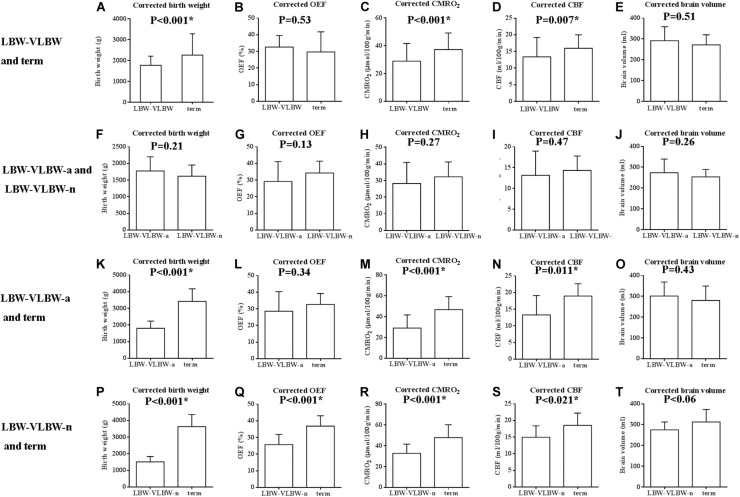
Box plots of corrected birth weight, OEF, cerebral metabolic rate of oxygen (CMRO2), cerebral blood flow (CBF), and brain volume, comparing low birth-weight/very low birth-weight (LBW-VLBW) and term newborns, LBW-VLBW-a and LBW-VLBW-n subsets, LBW-VLBW-a subset and term newborns, and LBW-VLBW-n subset and term newborns: (A,K,P) Corrected birth weights of LBW-VLBW newborns (+/-MRI abnormalities) exceeded by those of term newborns; (C,D,M,N,R,S) Corrected CMRO2 and CBF rates differed significantly in LBW-VLBW and term neonates (p < 0.001, p = 0.007), LBW-VLBW-a subset and term neonates (p = 0.001, p = 0.011), and LBW-VLBW-n subset and term neonates (p < 0.001, p = 0.021); (Q) Corrected OEF differed significantly in LBW-VLBW-n subset and term neonates (p < 0.001); (F–J) Corrected values similar (p > 0.05) in LBW-VLBW-a and LBW-VLBW-n subsets; and (B,E,L,O,T) Other values devoid of significant differences (p > 0.05), all data expressed as mean ± standard deviation.